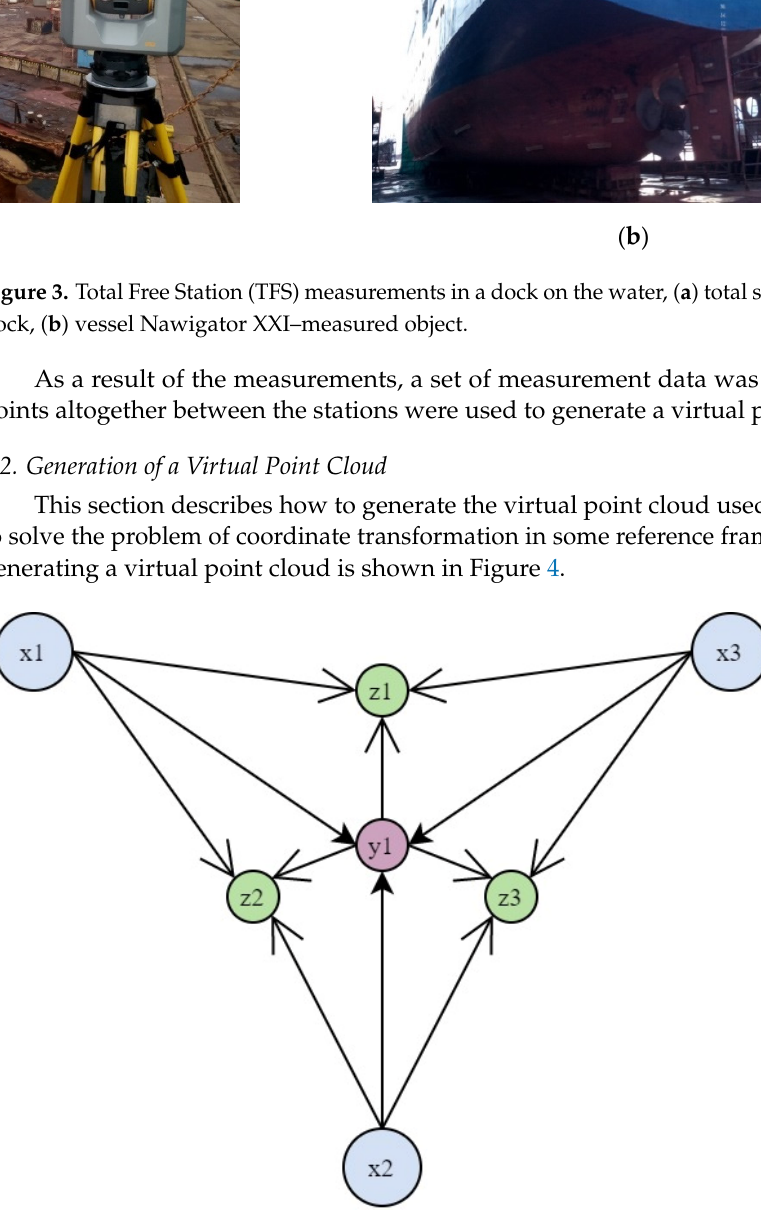
Figure 4. Generating a virtual point cloud, x1–x3–base points, y1–centroid, z1–z3–mean of the coordinates: 𝑥 , 𝑦, and 𝑧 .